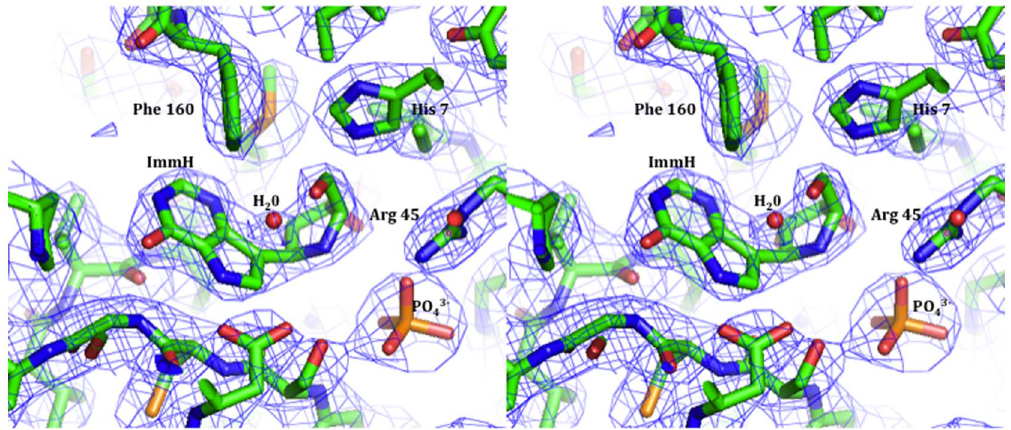
Figure 4. Catalytic Site of the V66I:V73I:Y160F PfPNP mutant. Cross-eyed stereo view of catalytic site of the triple mutant (V66I:V73I:Y160F) PfPNP showing bound ligand, ImmH, in a 2Fo-Fc map (blue) contoured at 1.0o´. The resolution for this map is 2.8 A˚. The figure was prepared with